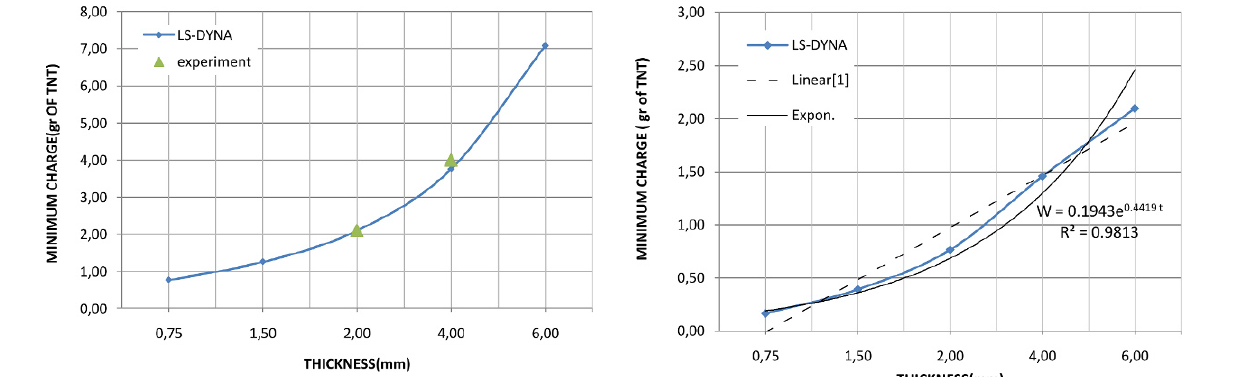
Figure 15. Linear and exponential approximations of the required charge for 100 mm diameter.